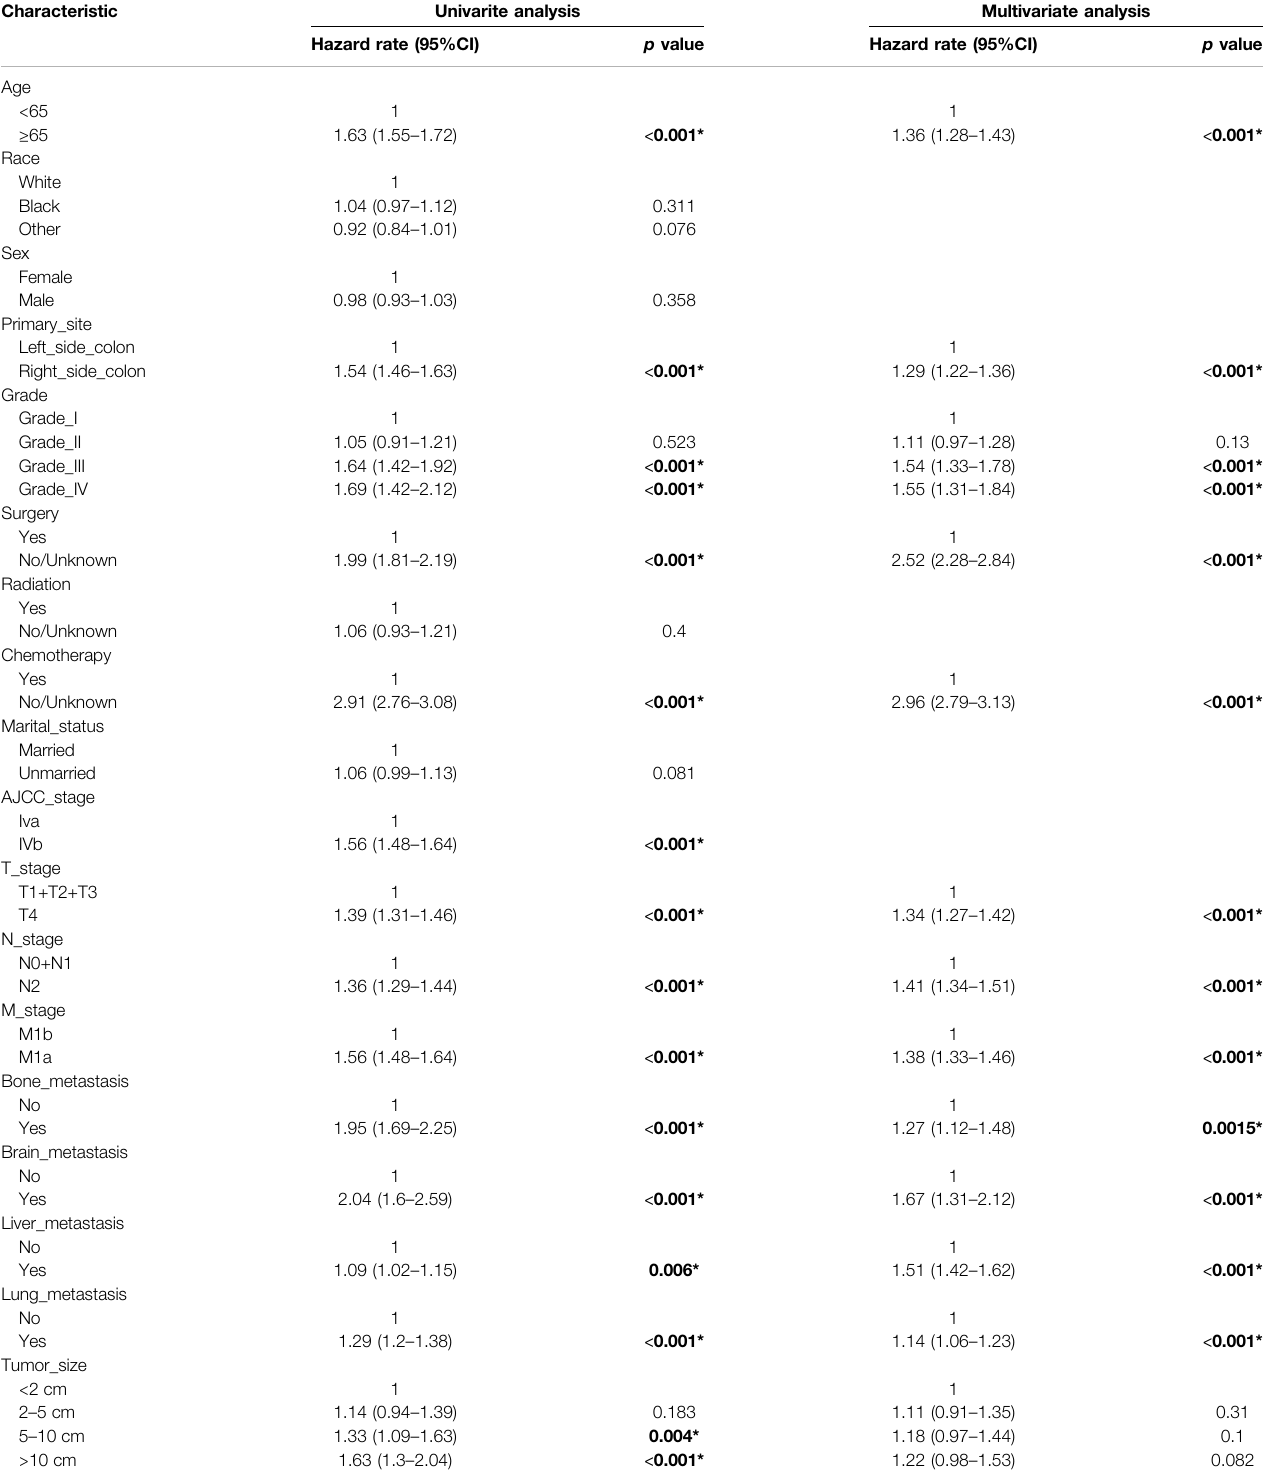
TABLE 2 | Univariate and multivariate analysis of training